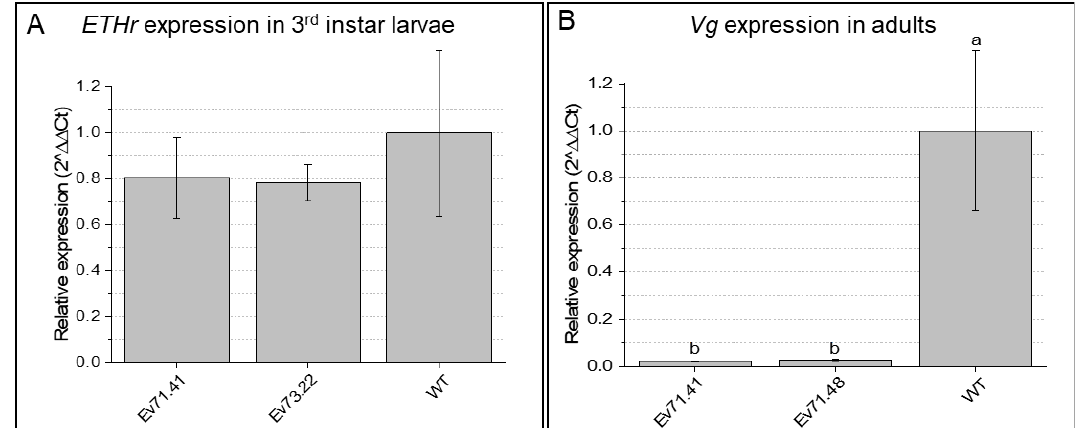
Figure 7. Relative expression of ecdysis-triggering hormone receptor ( ETHr ) and vitellogenin ( Vg ) genes mediated by RNAi in A. grandis individuals fed on dsRNA-expressing cotton. Individuals fed on transgenic cotton plants from different events (Ev) are compared with insects fed on wild-type cotton (WT). ( A ) Relative expression of ethr in third instar larvae after 15 – 18 days of feeding within cotton buds. ( B ) Relative expression of Vg in adult females after 30 days of feeding within cotton buds. N: 3 individuals per sample (3 samples per event). Different lowercase letters indicate significant differences between treatments ( t -test, Bonferroni corrected; p -value < 0.05).